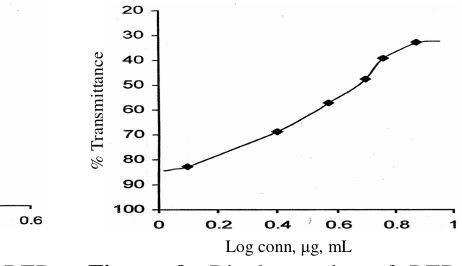
Figure 8. Ringbom plot of REB- EAA-conc. H